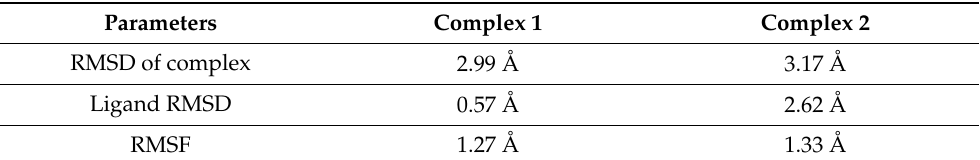
Table 3. Root mean square deviation and root mean square fluctuation for the top two complexes subjected to molecular dynamic simulation